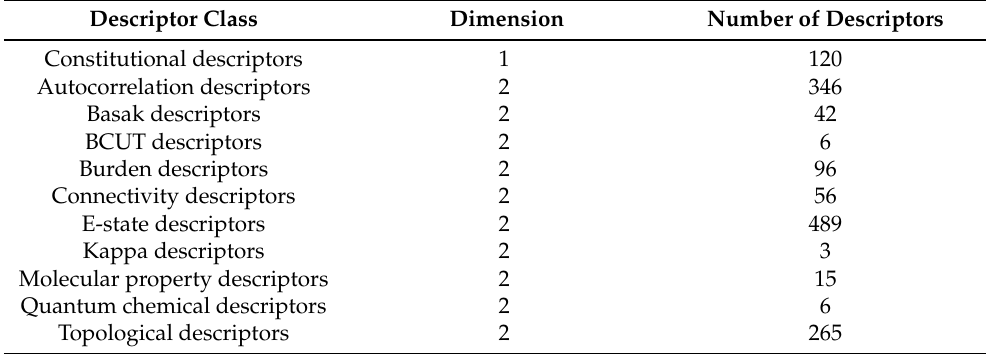
Table 2. The list of molecular